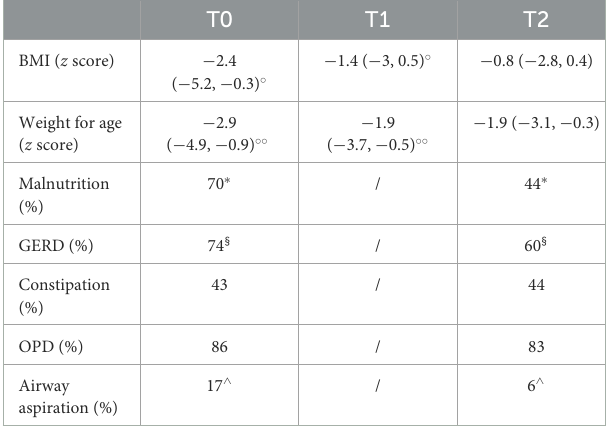
TABLE 4 Malnutrition and digestive co-morbidity after HEN